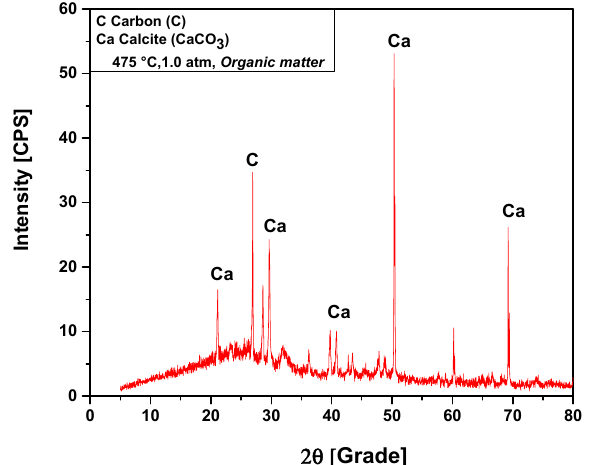
Figure 12. XRD of solid phase products by pyrolysis of (organic matter + paper) fraction of MHSW at 475 °C, 1.0 atm, using a borosilicate glass reactor of 125 mL, in laboratory scale.